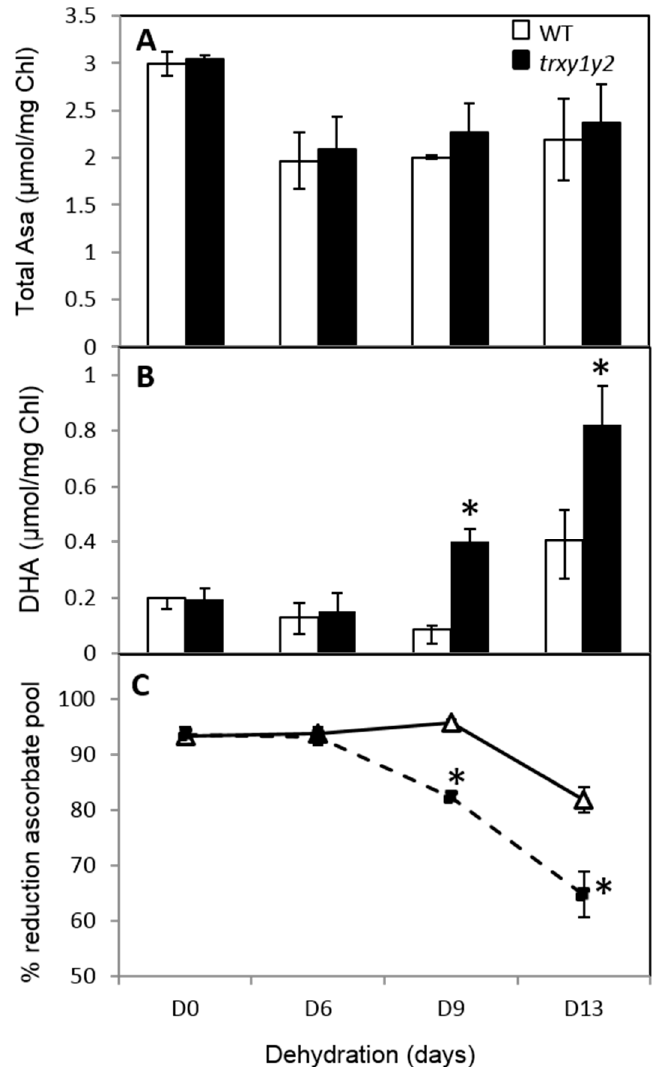
Figure 6. Effect of drought on the ascorbate pool size and redox state. Ascorbate (AsA) pool after dehydration in leaves from Col-0 (open bars or triangles) and in double trxy1y2 mutant (dark bars or squares). ( A ) Total AsA content; ( B ) Oxidized AsA (DHA) content; ( C ) Redox state of the ascorbate pool. Data correspond to means ± SD ( n = 4, from 2 independent experiments). Mutant samples significantly different from WT ( p < 0.05) are indicated by an asterisk (*).